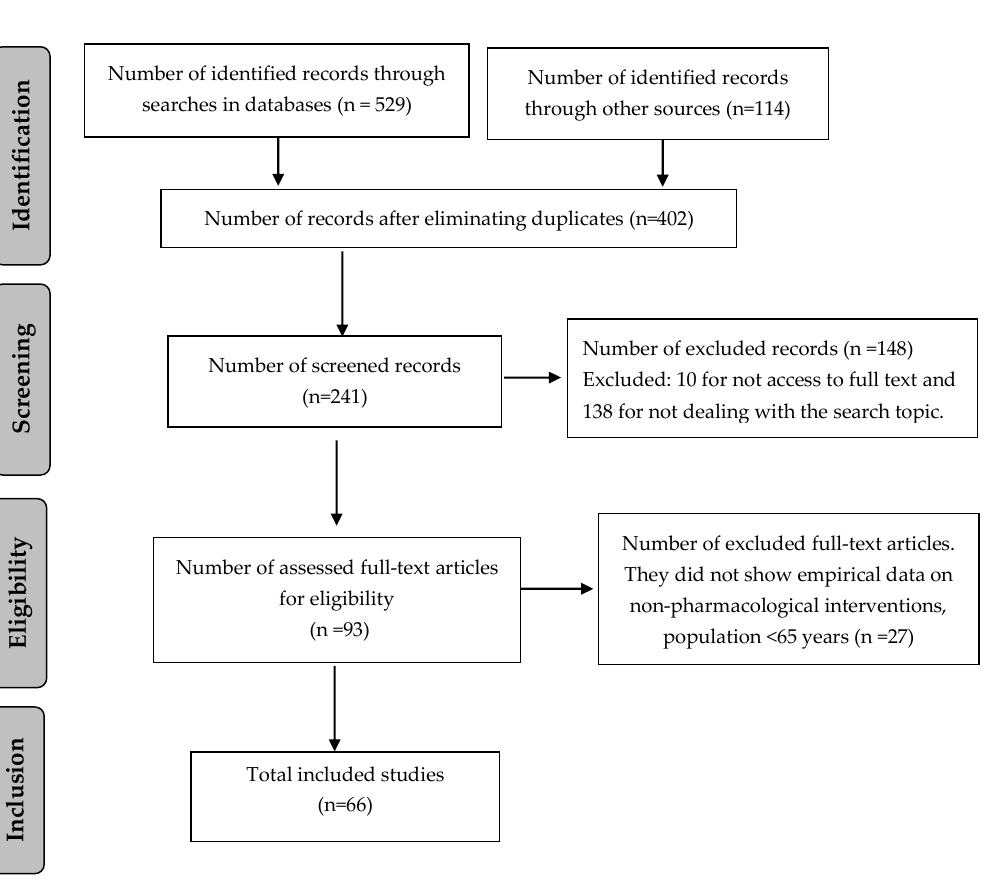
Figure 1. Flow chart of screening process.